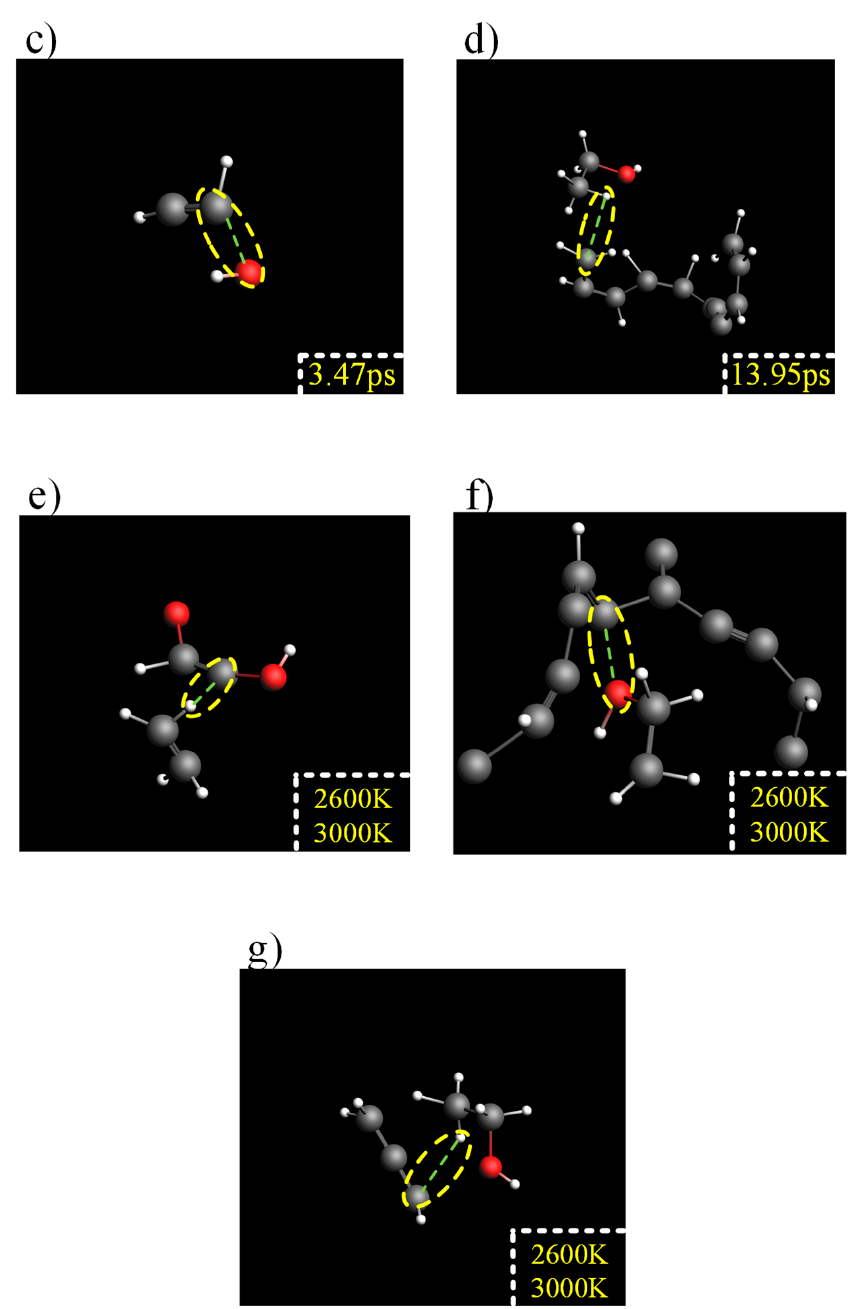
Figure 9. ( a – g ) The curve of ethanol molecules.